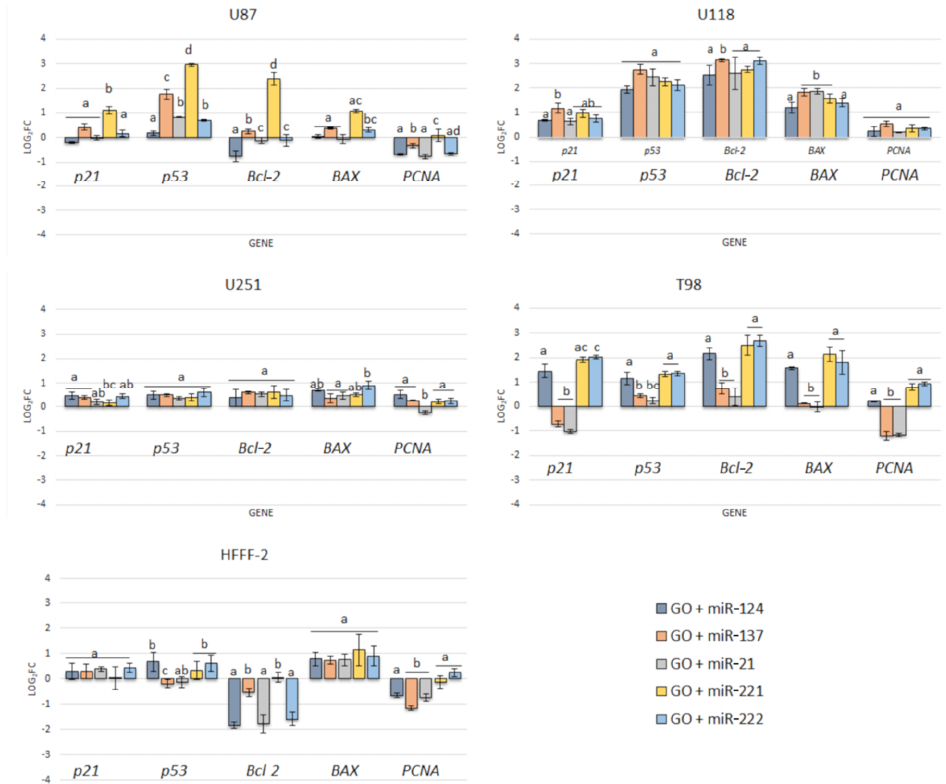
Figure 16. Expression of genes p21, p53, Bcl-2, BAX and PCNA at the mRNA level in U87, U118, U251 and T98 glioblastoma and HFFF-2 fibroblast cells after 24 h graphene oxide + miRNA nano transfection using RT-PCR. Bars represent means with standard deviation (SD) ( n = 3). Relative expression was calculated using the gapdh gene and the control group (0). The results are presented as log 2 FC values. Values above/below 0 indicate upregulation/downregulation of gene expression. FC fold change. Notes: Different lowercase letters (a, b) within columns indicate significant differences between the miRNAs ( p <